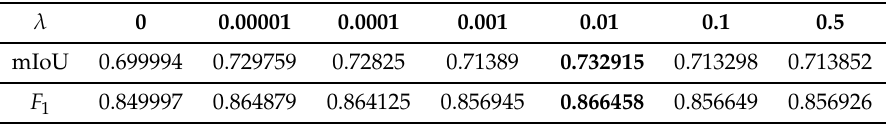
Table 8. The performance output for different parameters λ of normalized cut combined with the partial loss function in dataset 2